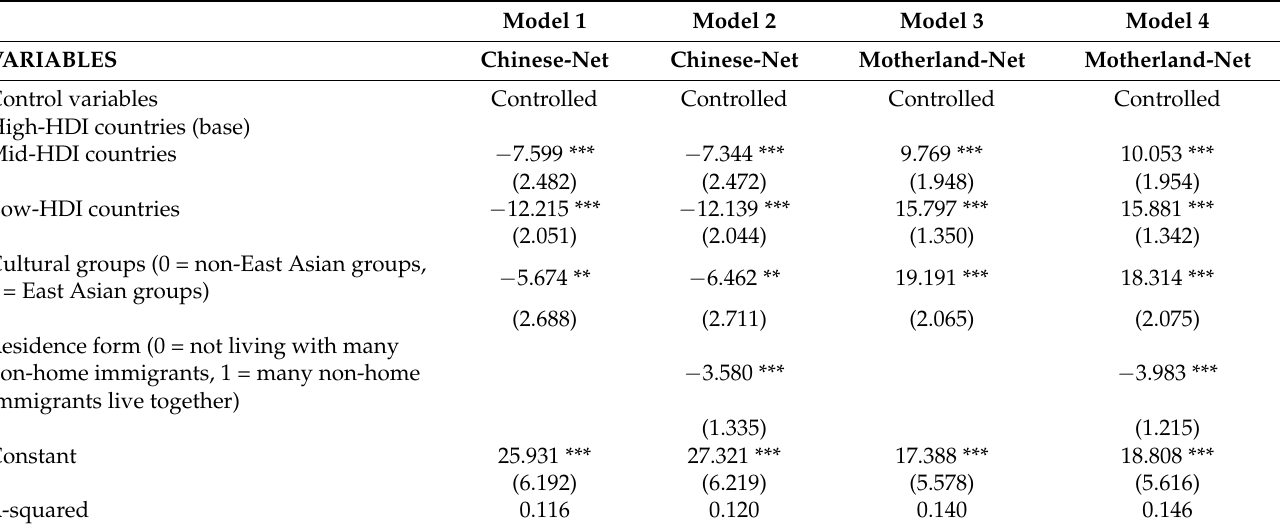
Table 1. Multivariable linear regression model of migration network differences (N = 1624). Model